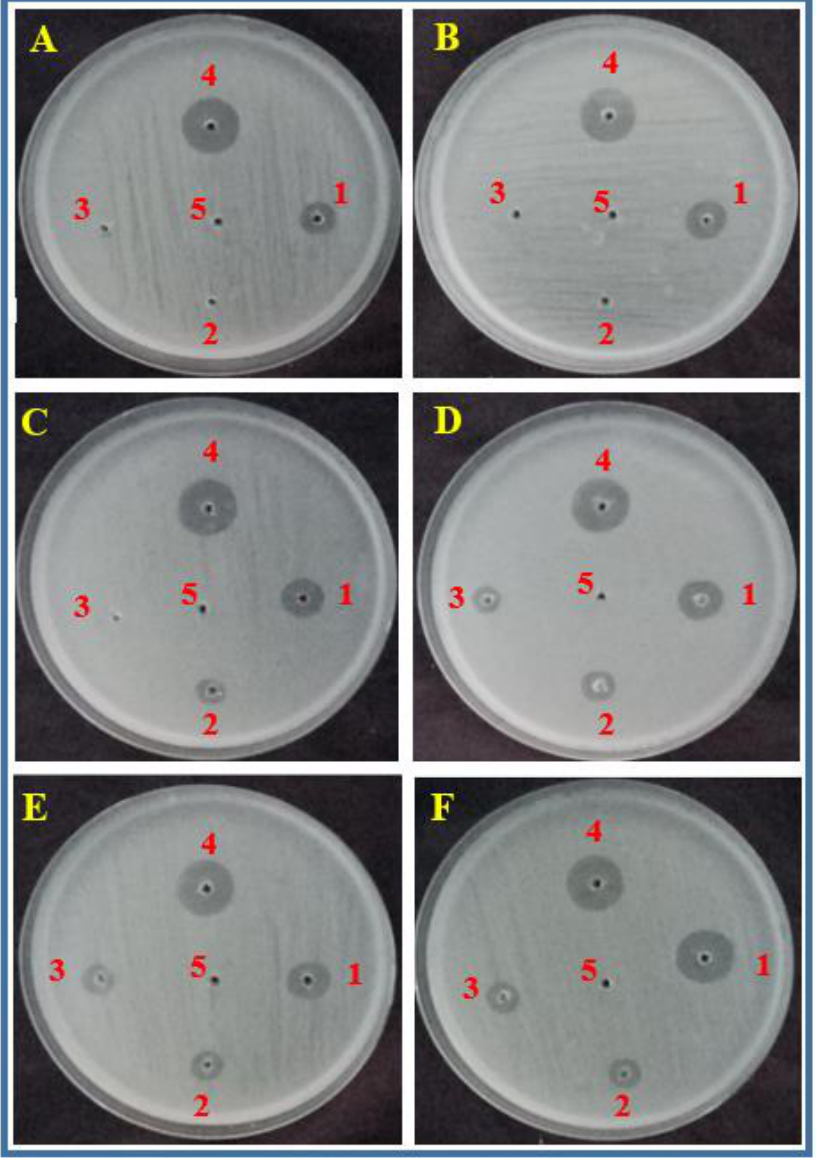
Figure 4. Zones of inhibition produced by Berberis vulgaris fruit extracts. 1: Jilin province, 2: Hei- longjiang province, 3: Liaoning province, 4: Positive control (antibiotic) and 5: negative control (methanol) against food born bacteria ( A ): S. aureus , ( B ): L. monocytogenes , ( C ): E. coli , ( D ): P. fluorescens , ( E ): V. parahaemolyticus and ( F ): A. caviae.